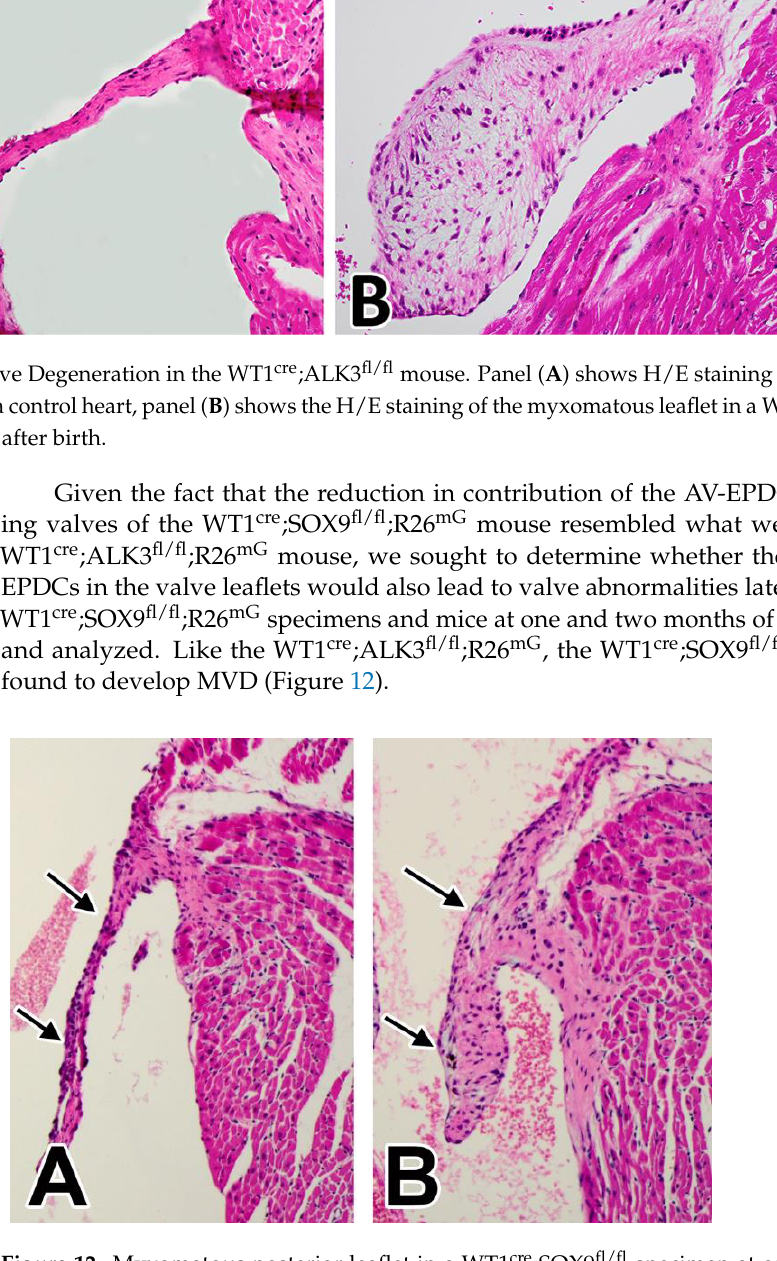
termine the level of expression of GAGs and proteoglycans in the postnatal